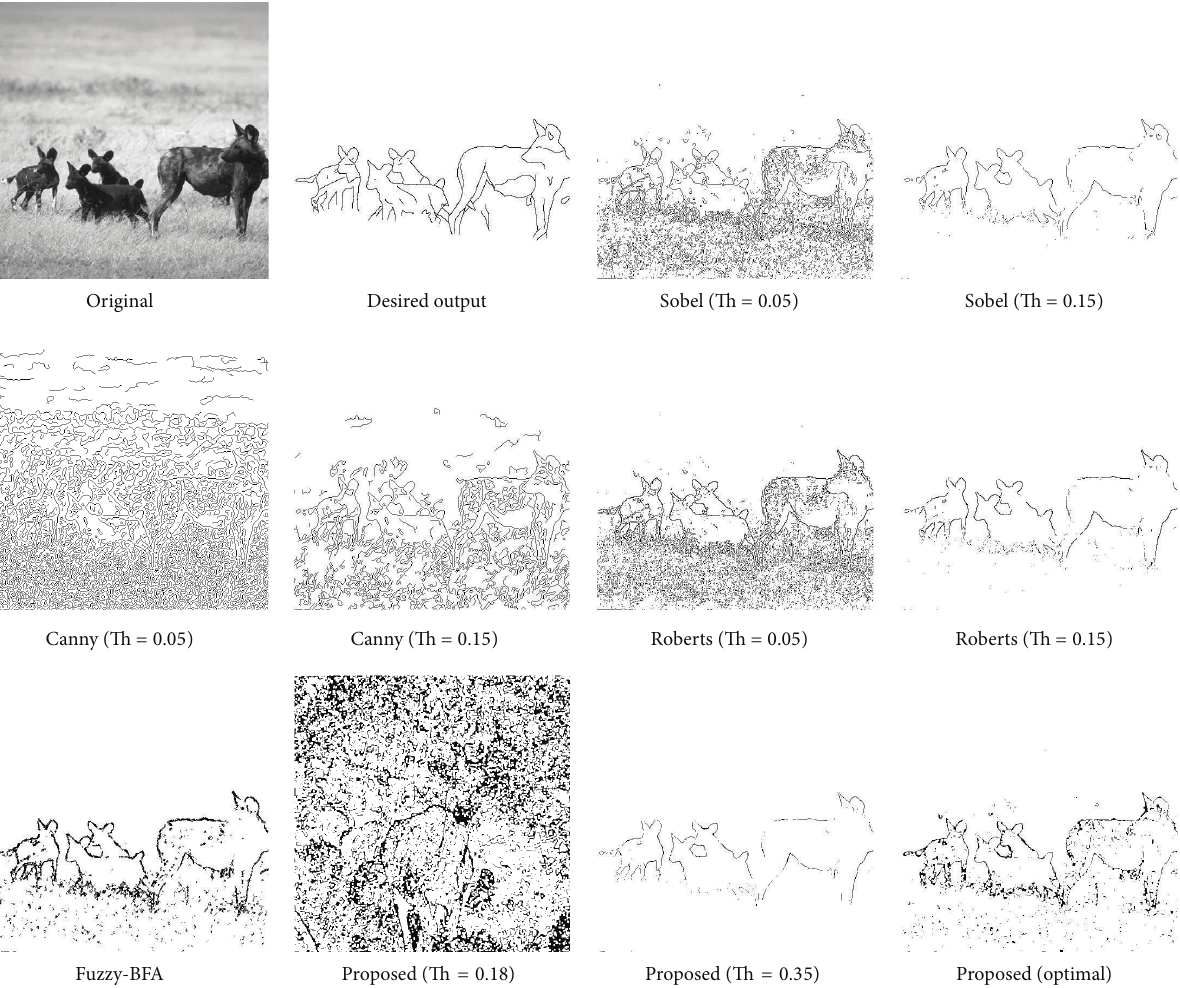
Figure 6: Edge detection results of “hyena” image: desired edge output of “hyena” image; Sobel, Canny’s, and Roberts methods using thresholds = 0.05 and 0.15; fuzzy-BFA method; proposed method with fixed thresholds (0.18 and 0.35) and optimal